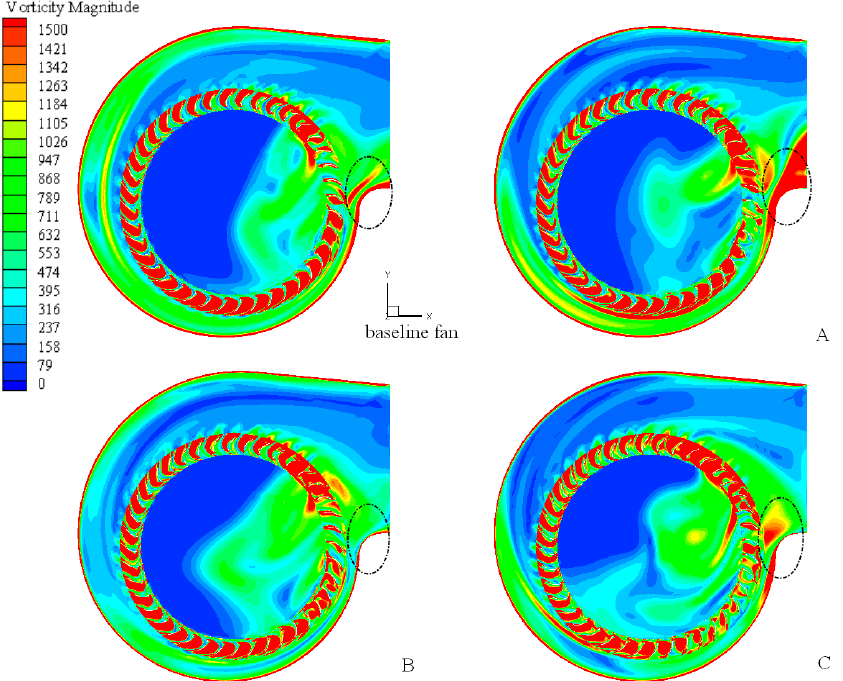
Figure 19. Contour of vorticity magnitude for the z = 35 mm plane at a high flow rate Q / Q n = 1.760: ( A ) model-A; ( B ) model-B; ( C ) model-C.